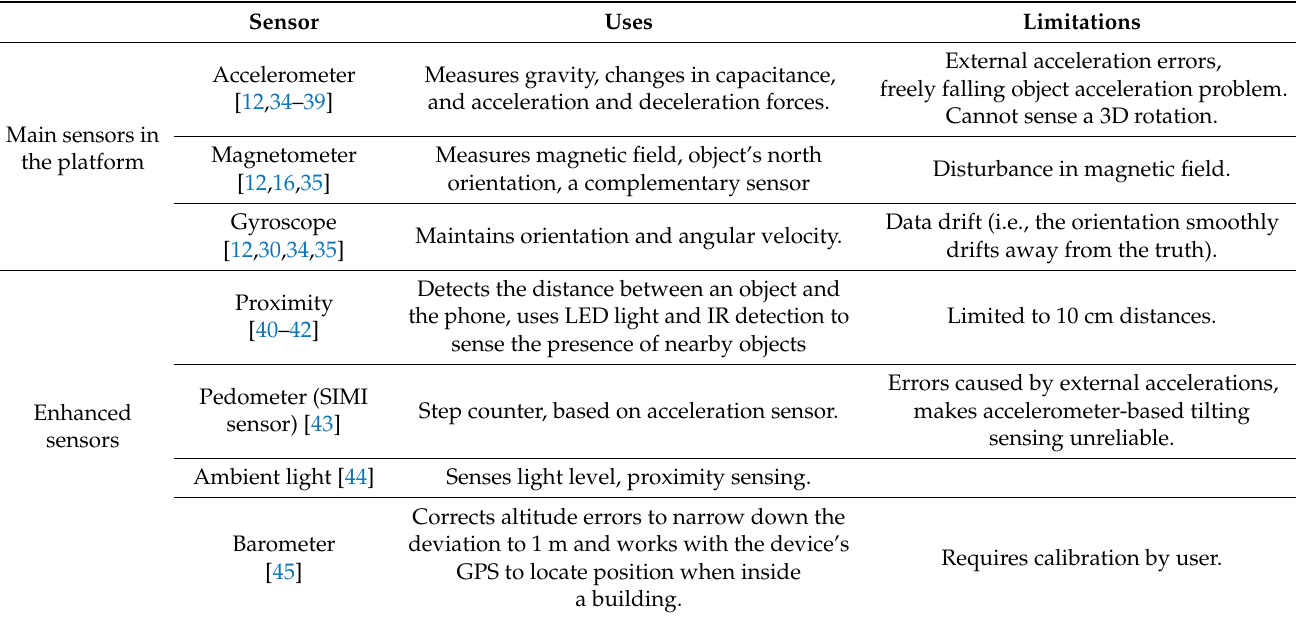
Table 1. Details of various handheld device